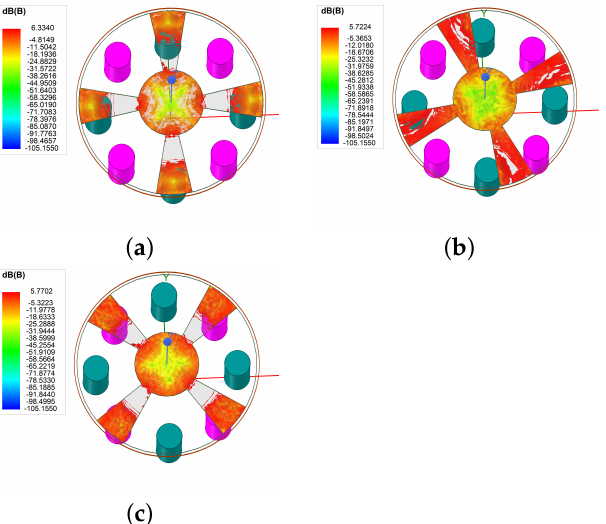
Figure 3. B-field distribution on the rotating shutter at different times: ( a ) t = 0 s; ( b ) t = 0.667 ms; ( c ) t = 1.67